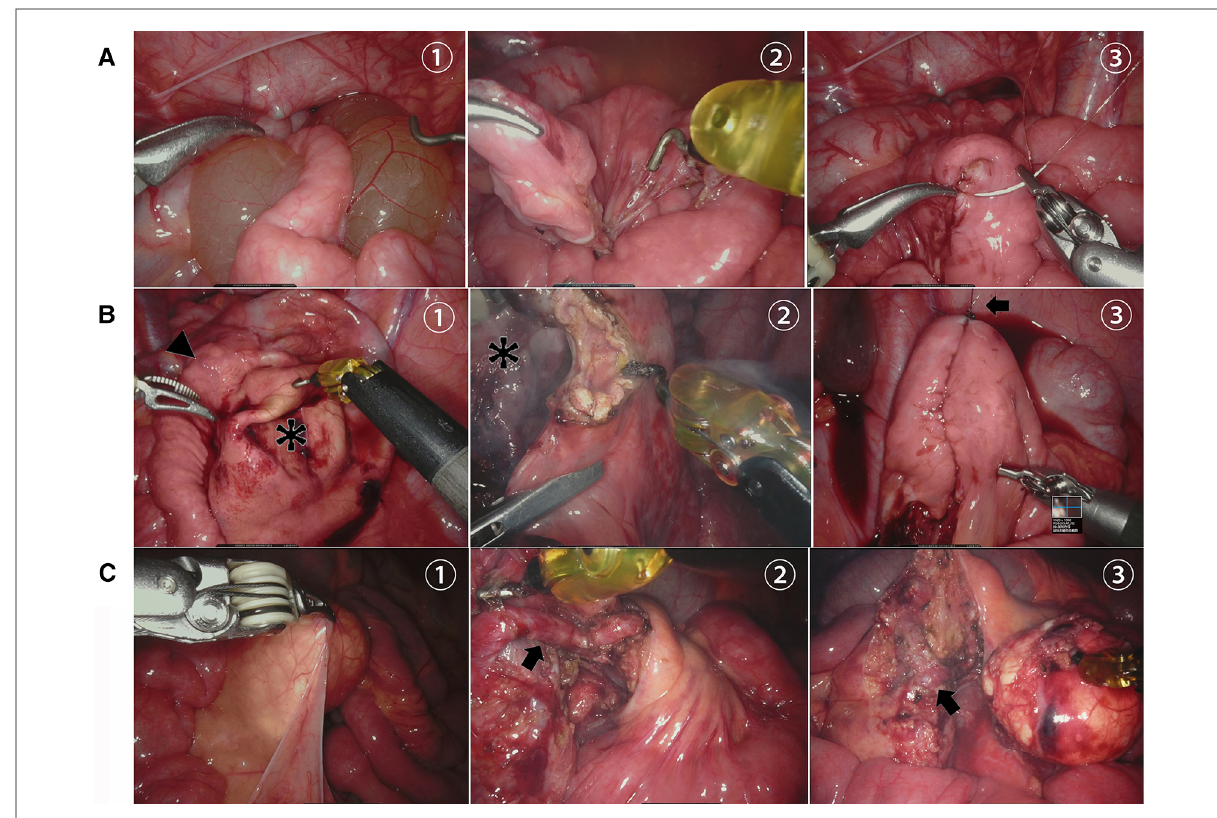
FIGURE 4 Robot-assisted laparoscopic removal of MCs. ( A ) (1) Serous cyst (asterisk) penetrating through the mesentery of the ileum, (2) complete removal of the cyst without bowel resection, and (3) repair of the mesenteric defect. ( B ) (1) Milky white cyst (asterisk) located at the root of the intestinal mesentery, (2) cyst stripped off the mesenteric vessel, and (3) mesenteric vessels (arrow) preserved intact after cyst resection. ( C ) (1) Huge cyst (asterisk) located in the mesentery of the ileum (arrowhead) after aspiration, (2) cyst removed with segmental bowel resection, and (3) intra- abdominal intestinal anastomosis with the assistance of bowel suspension and traction